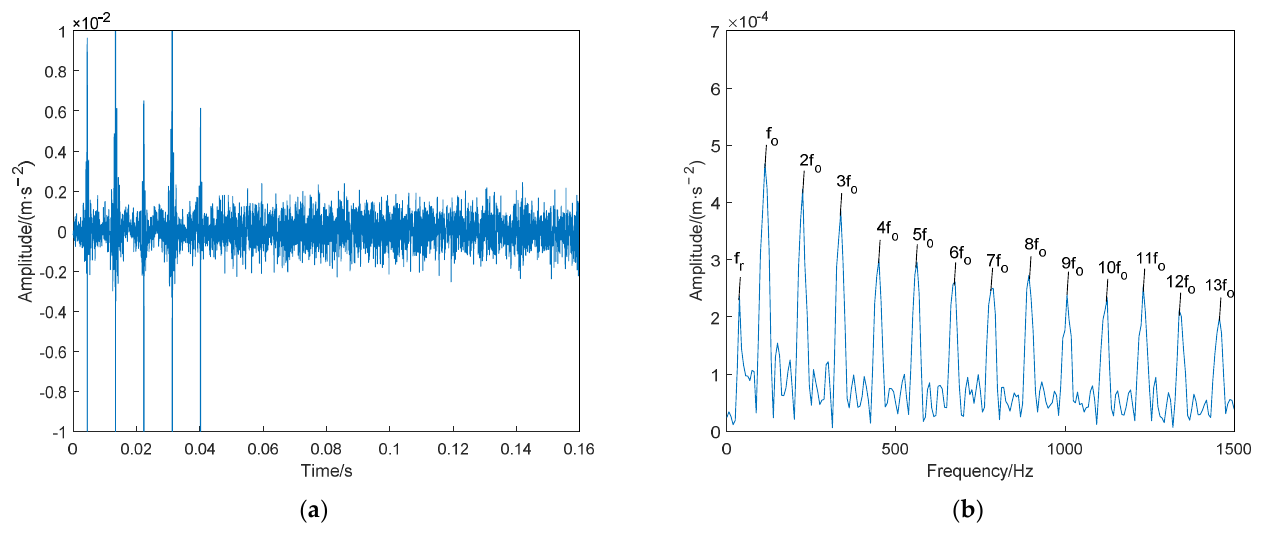
Figure 26. The fitness function varies with the number of iterations. After setting the parameters in MCKD according to the optimal parameter combination obtained, the time-domain waveform and envelope spectrum obtained by deconvolution analysis of the optimal components, using MCKD, are shown in Figure 27.